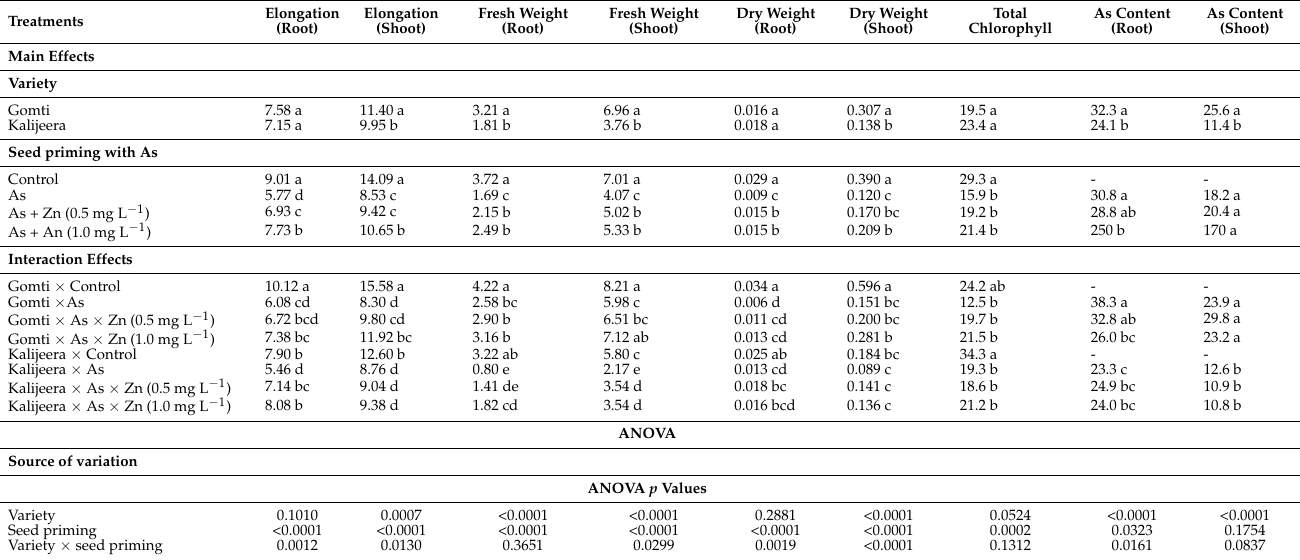
Table 1. Consequences of seed priming with Zn 2+ on rice seedling growth, chlorophyll content and As-accumulation pattern grown under As